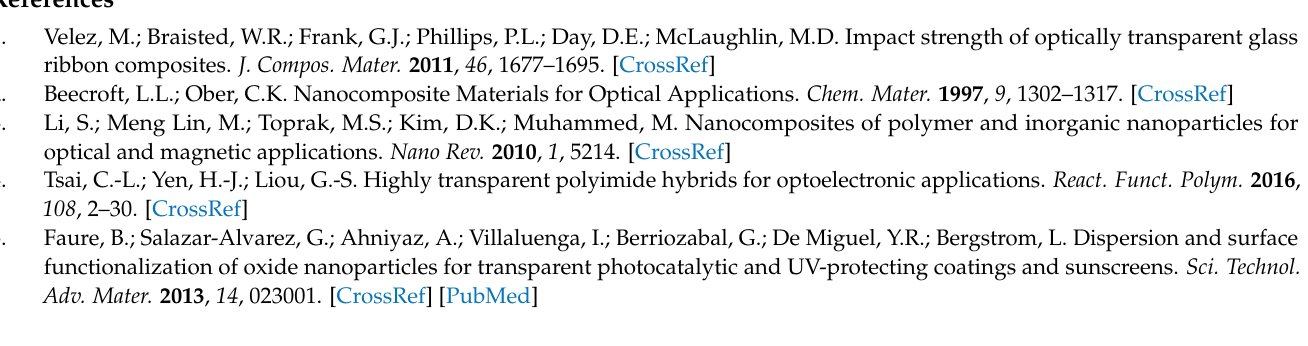
29-layer sample prepared by RTM, Figure S3: DSC results of the RTM samples, Table S1: Summary of the properties of selected fiber-reinforced composites from the